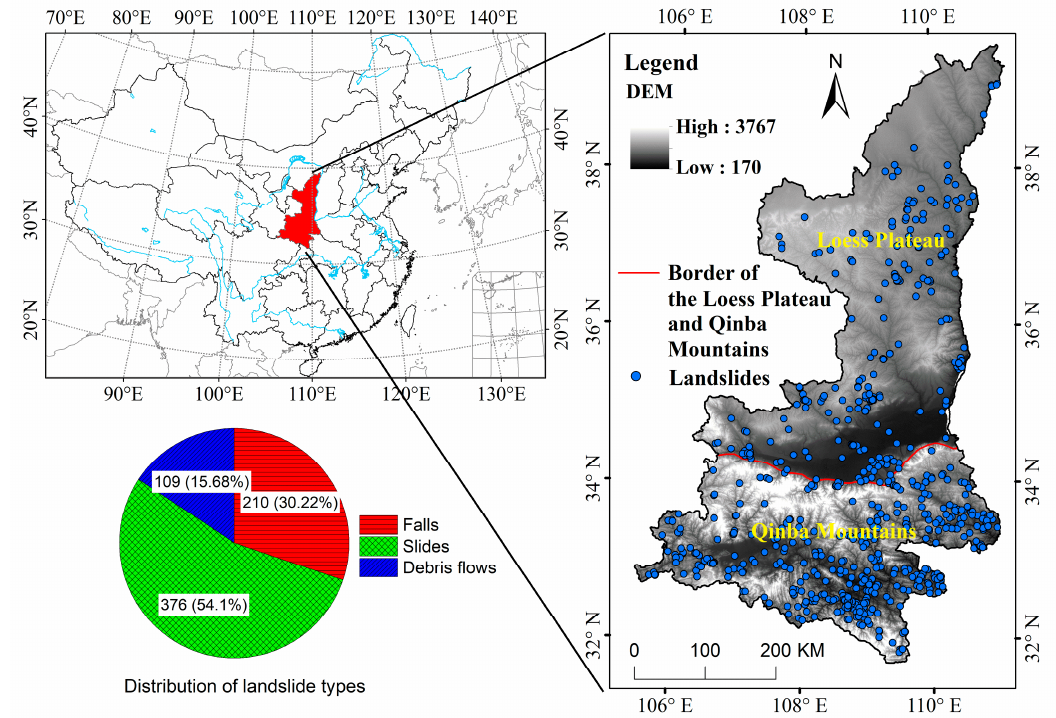
Figure 1. Location of the study area and digital elevation model (DEM). The inset shows the position of Shaanxi Province.